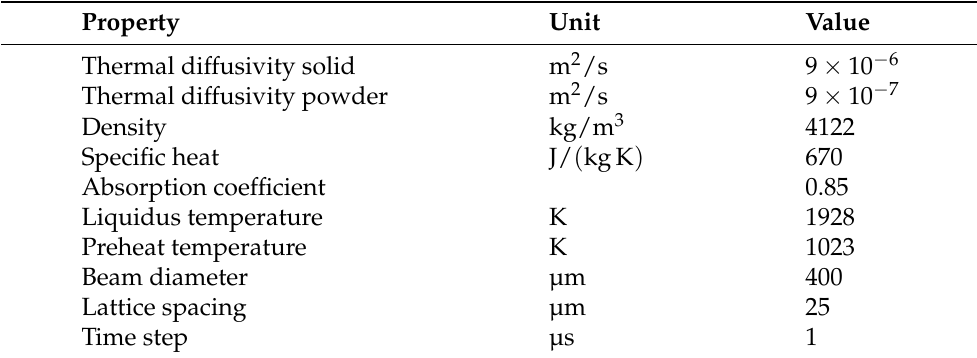
Table 1. Material properties for Ti-6Al-4V [39,40] and simulation